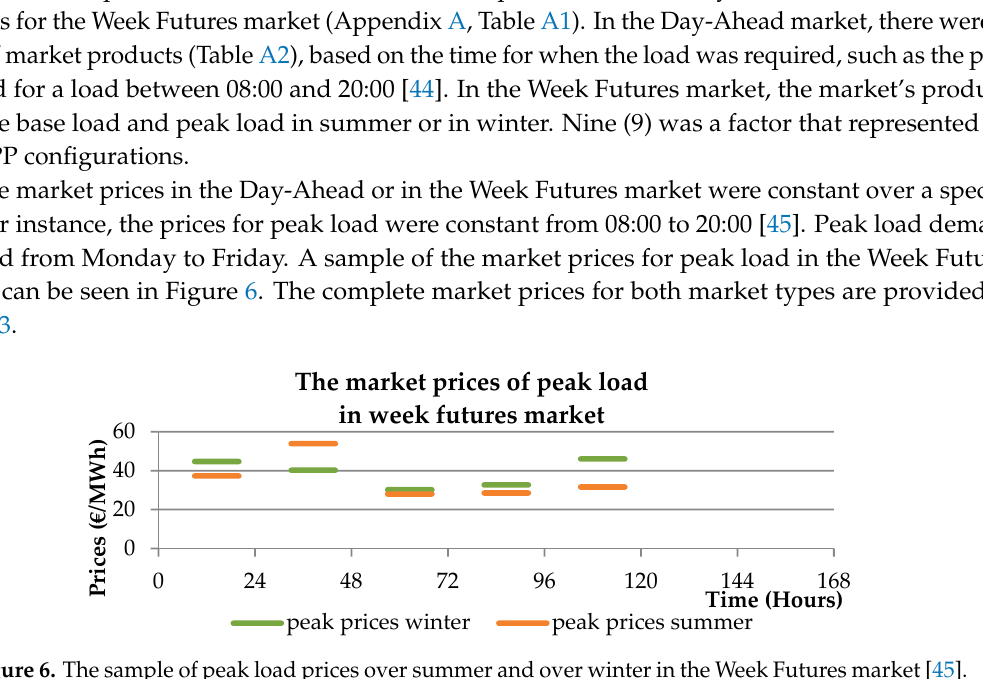
Figure 6. The sample of peak load prices over summer and over winter in the Week Futures market [45].